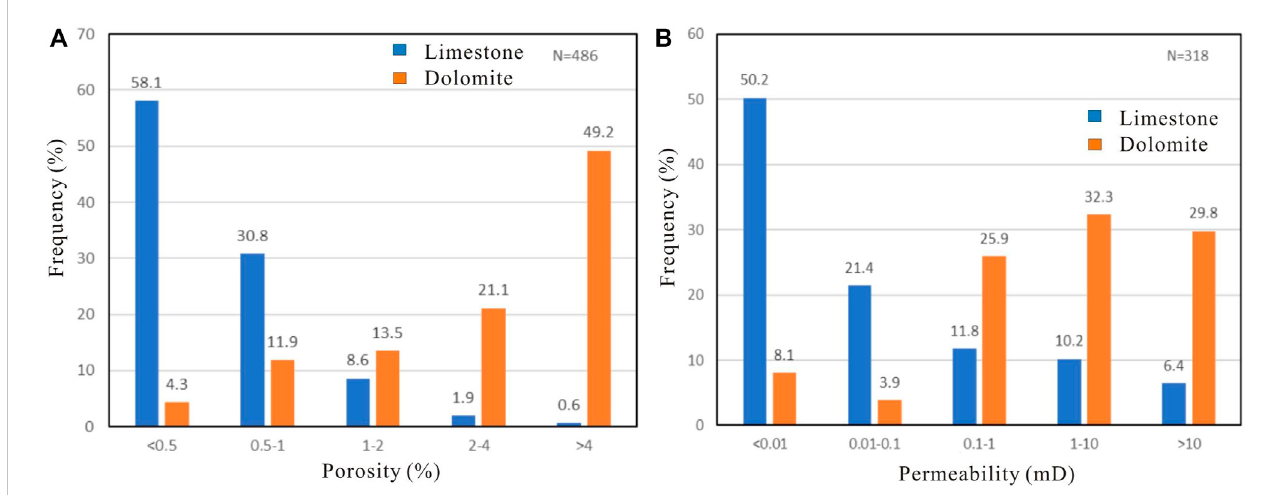
FIGURE 5 Histograms of physical property distribution of limestones and dolomites in Permian Qixia Formation in central Sichuan Basin. (A) Porosity distribution histogram; (B) Permeability distribution histogram.